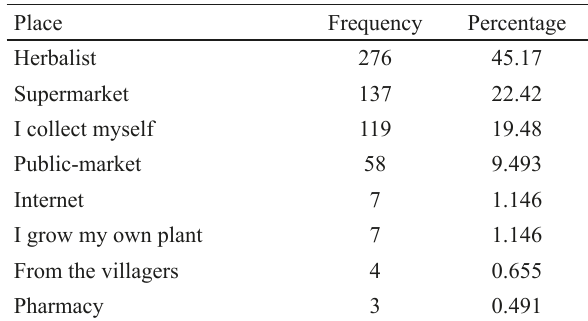
Table 4. Distributions of Places where Participants Purchase Medicinal and Aromatic Plants.